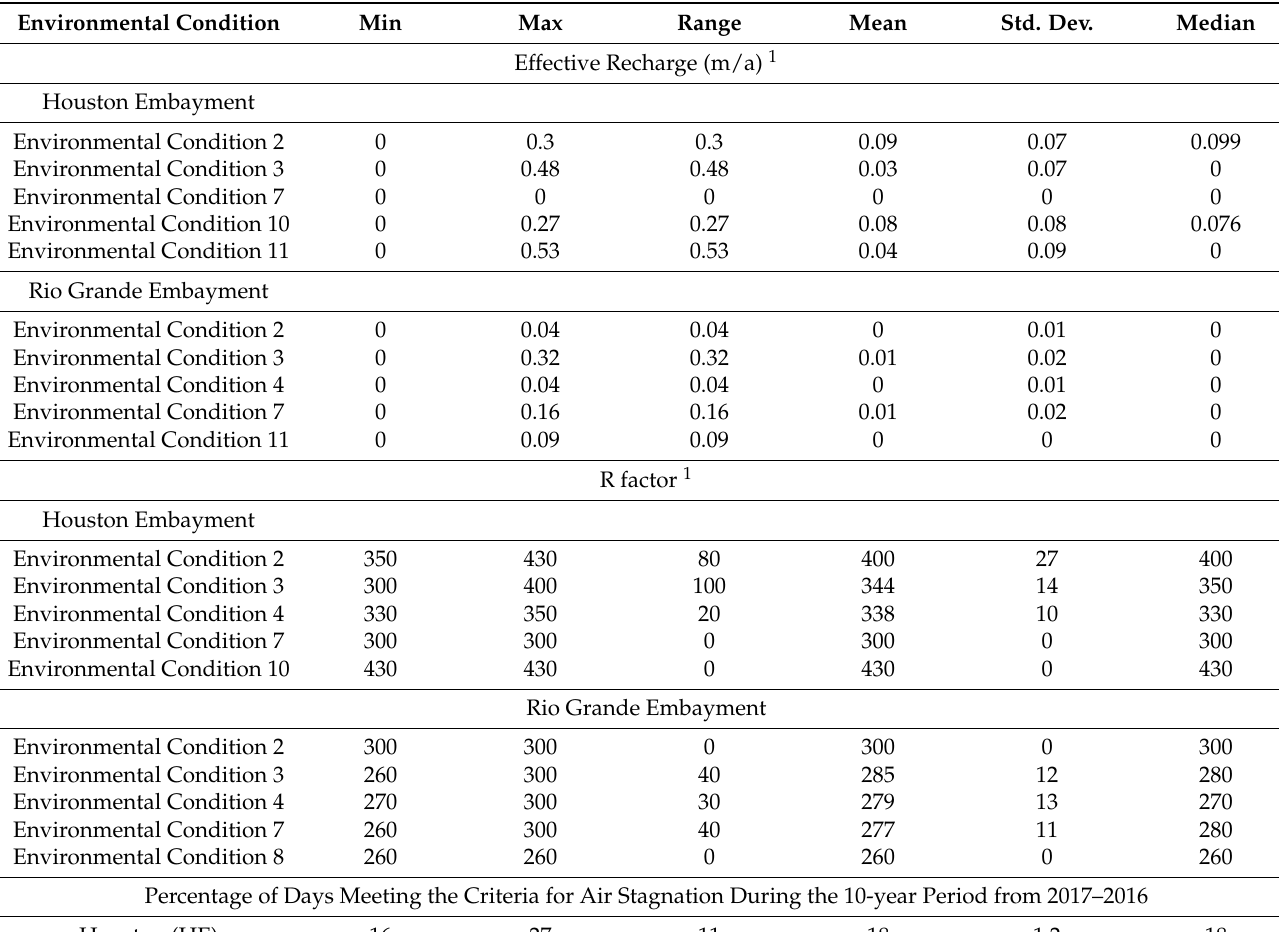
Table 3. Summary statistics for the Rio Grande Embayment and the Houston Embayment within the Permissive Track